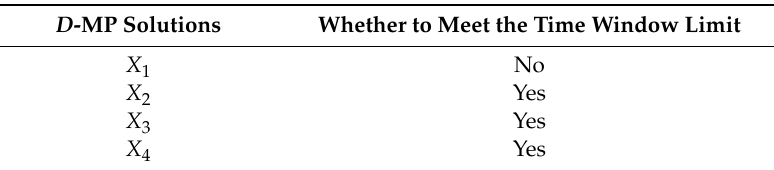
Table 24. The results of Step 4.